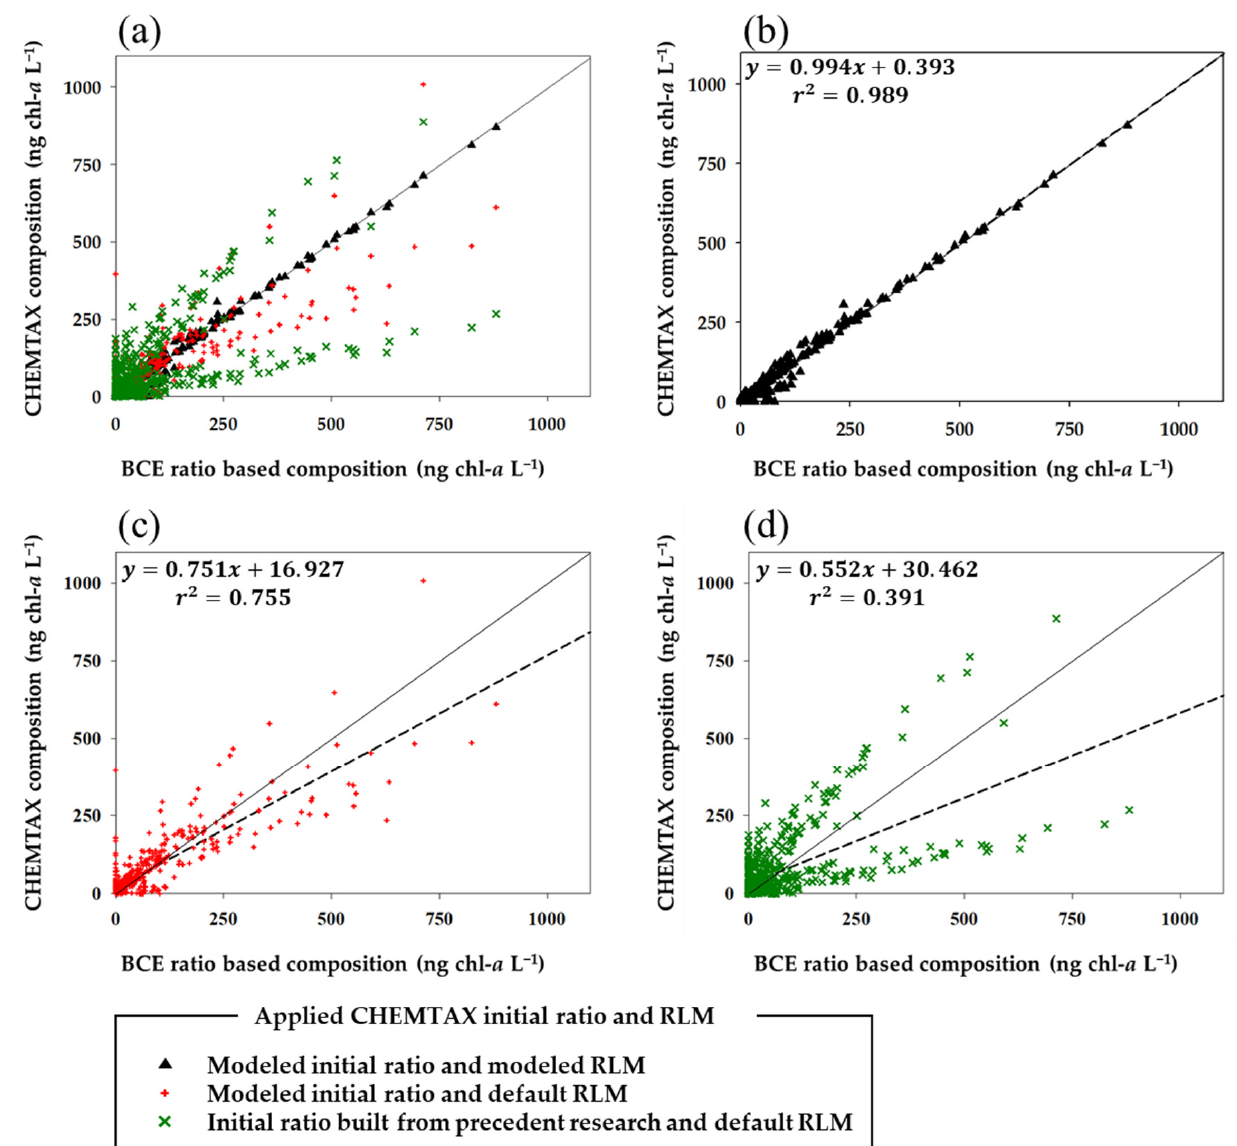
Figure 4. Regression analysis of composition data derived from BCE final ratios and ( a ) all CHEMTAX final ratios and those based on ( b ) modeled initial ratios and ratio limits, ( c ) modeled initial ratios and the default ratio limit, ( d ) and initial ratios built from precedent research [27] (Table 2) with default ratio limits. Dashed and solid lines are regression and 1:1 lines, respectively.